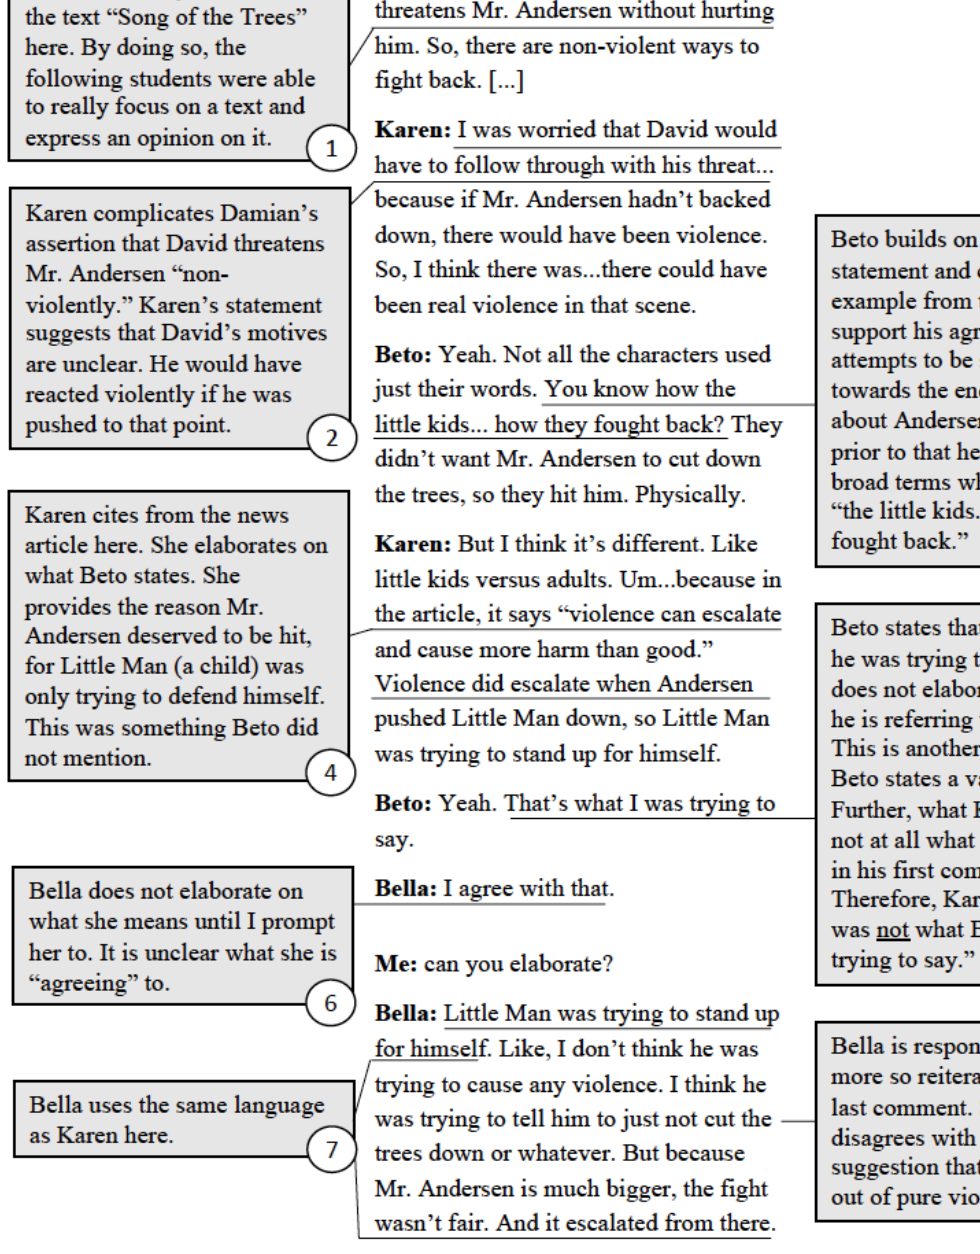
Figure 3: Focal Students’ Socratic Seminar Excerpt with Nina’s Analytic